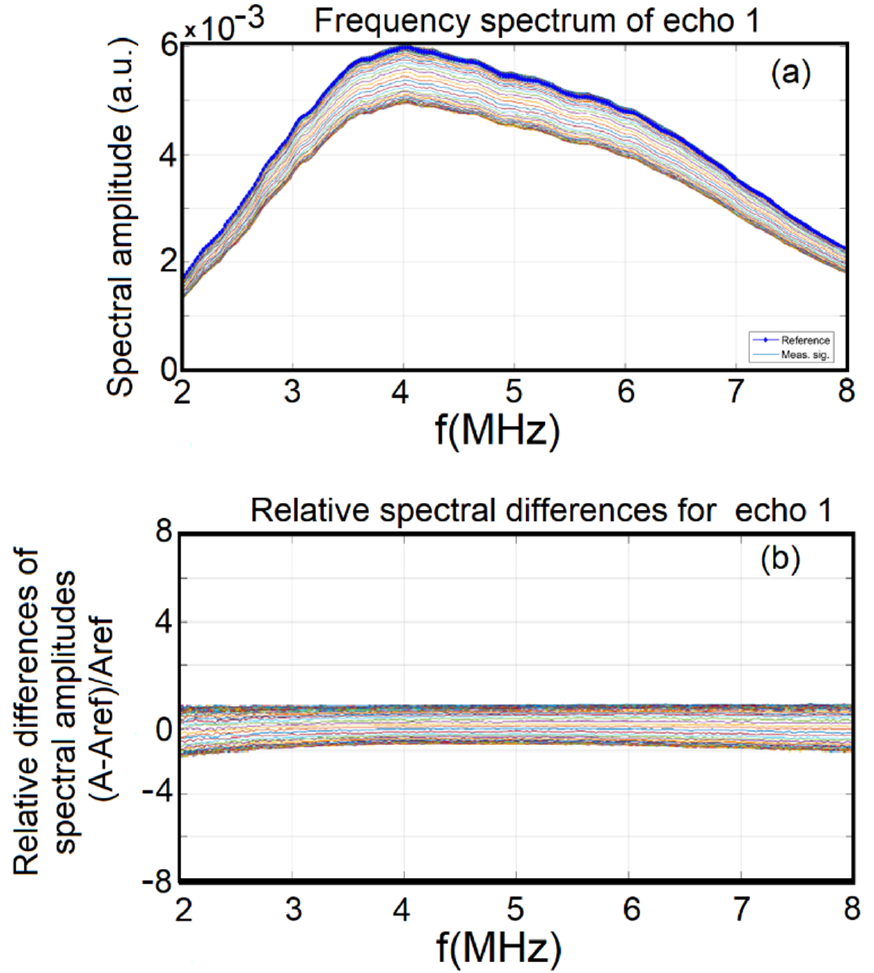
Figure 2. Each recorded signal processed and the frequency spectra ( a ), and the relative difference of spectral amplitudes during the experiment ( b ), of NBrHAp suspension.